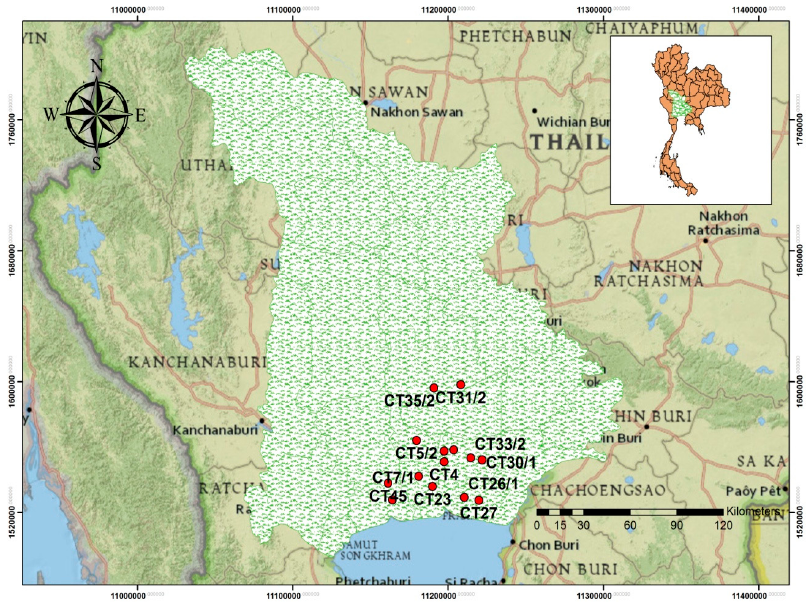
Figure 1. Location of study area and observations wells in the lower central plains of Thailand.